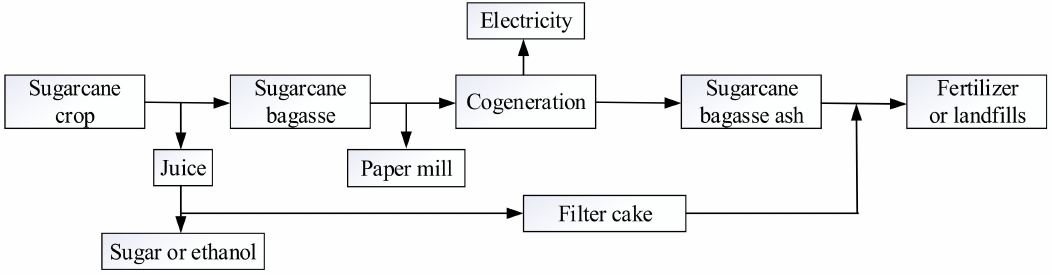
Figure 1. The generation process of SCBA in a sugar